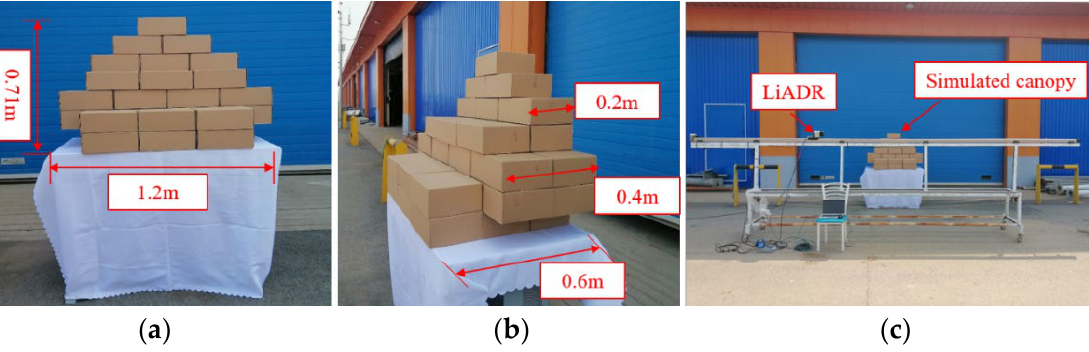
Figure 5. Simulated canopy test: ( a ) canopy front; ( b ) canopy side; ( c ) LiDAR detection process.